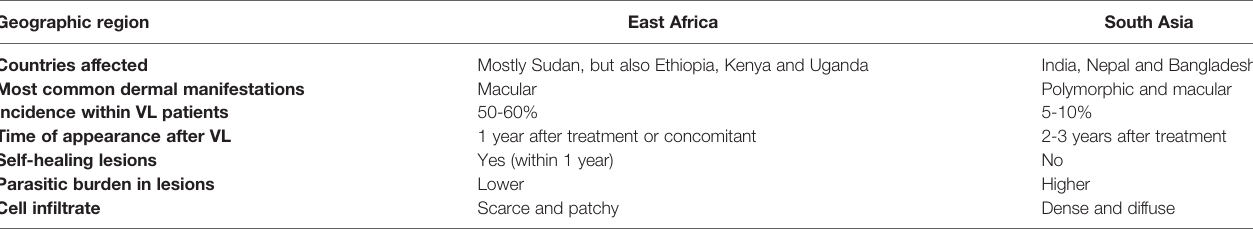
TABLE 2 | Comparison between PKDL in the two main endemic regions in the Old World. Geographic